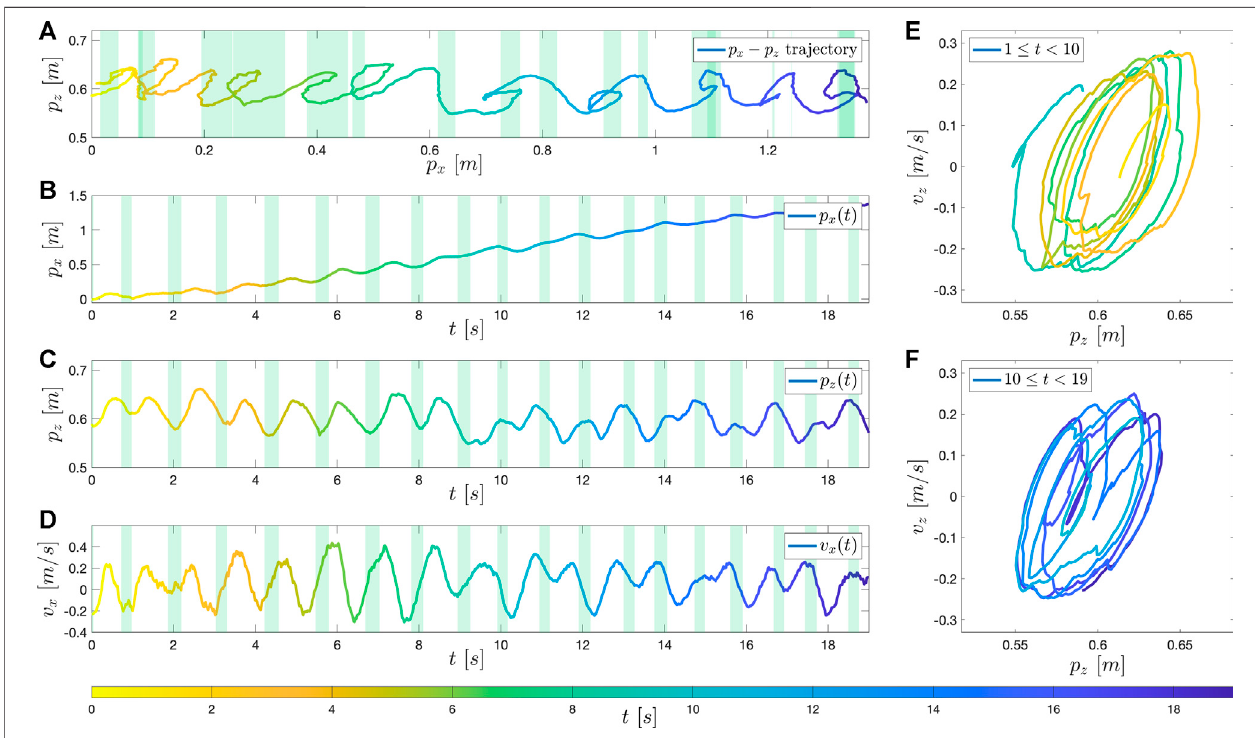
FIGURE10| Theresultonthehardware. (A) showsthetrajectoryofthepelvisinthesagittalplane(X-Zplane). (B – D) showsthe p x , p z , v x ofthepelvisover time. (E) and (F) are the phase plots of the pelvis in Z-coordinate: (E) in an earlier phase (1 s ≤ t ≤ 10 s), and (F) in a later phase (10 s ≤ t ≤ 19 s).